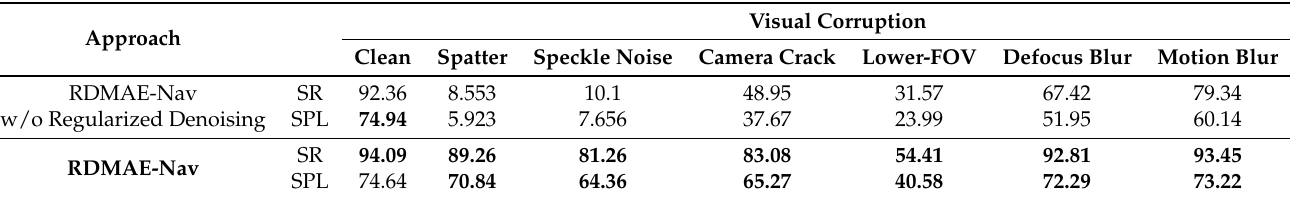
Figure 11. Histogram of contributions of Regularized Denoising on the navigation performance of RDMAE-Nav. Table 5. Detail of contributions of Regularized Denoising on navigation performance of RDMAE-Nav.